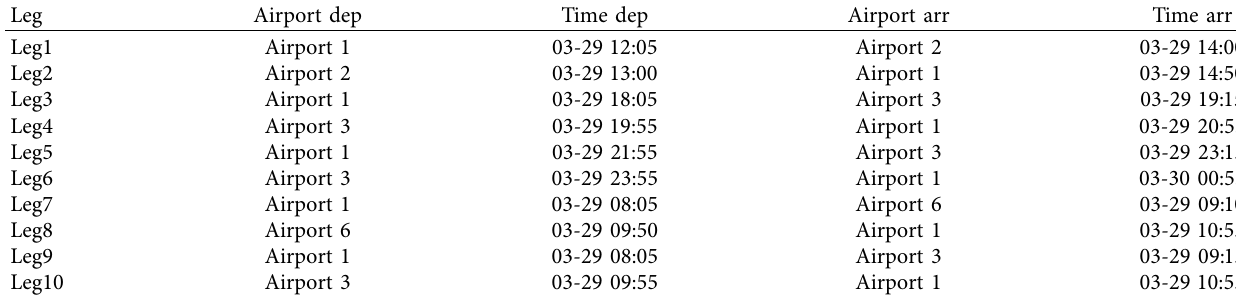
Table 1: Flight segment information table.